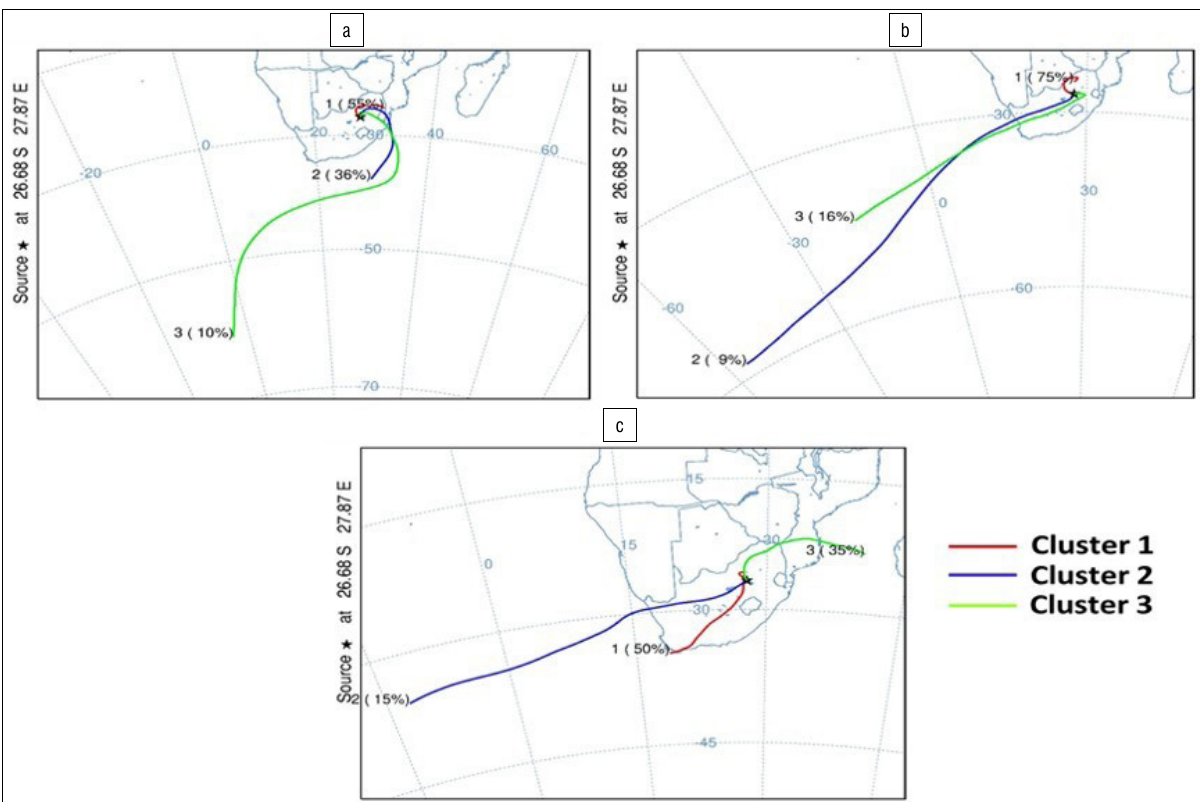
Figure 7: Backward trajectory cluster means for the (a) summer/autumn, (b) winter and (c) spring sampling